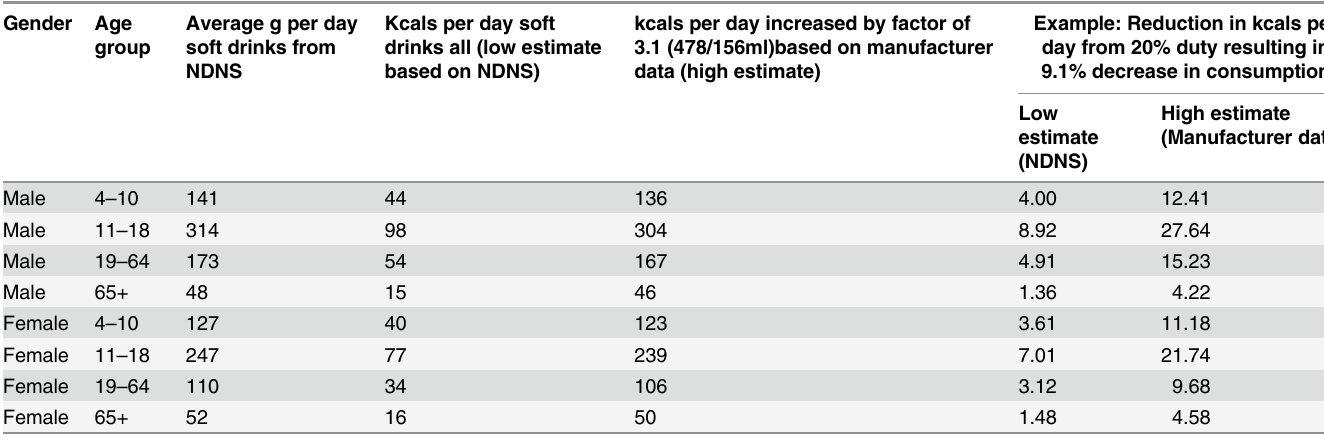
Table 1. Average consumption per day of SSBs and impact of a 20% duty on calories (low and high estimates), data by gender and age group, based on NDNS data for 2008 – 10 [20]. Gender Age